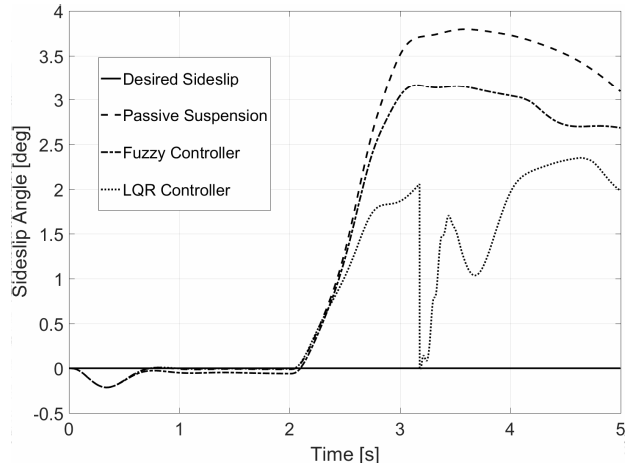
Figure 9. Sideslip for Test